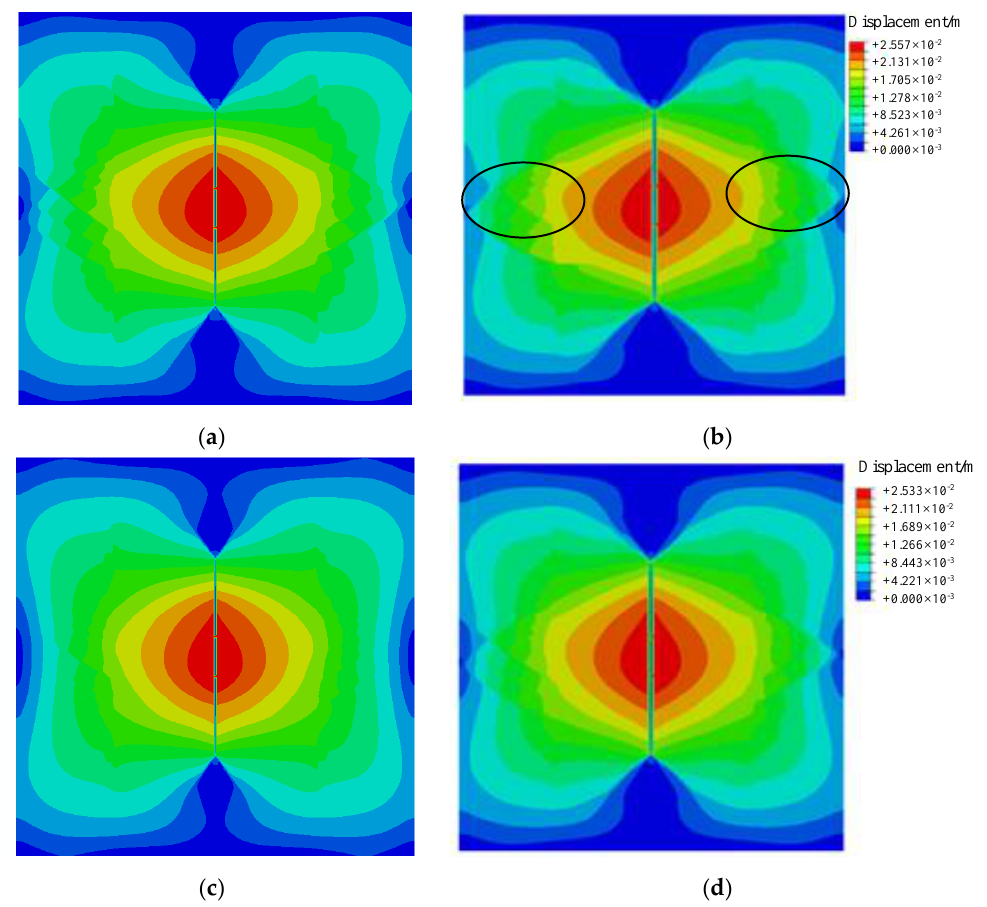
Figure 10. Cloud picture of displacement field under different cohesion values: ( a ) cohesion of 8 MPa and t = 55 s; ( b ) cohesion of 8 MPa and t = 100 s; ( c ) cohesion of 12 MPa and t = 55 s; and ( d ) cohesion of 12 MPa and t = 100 s.